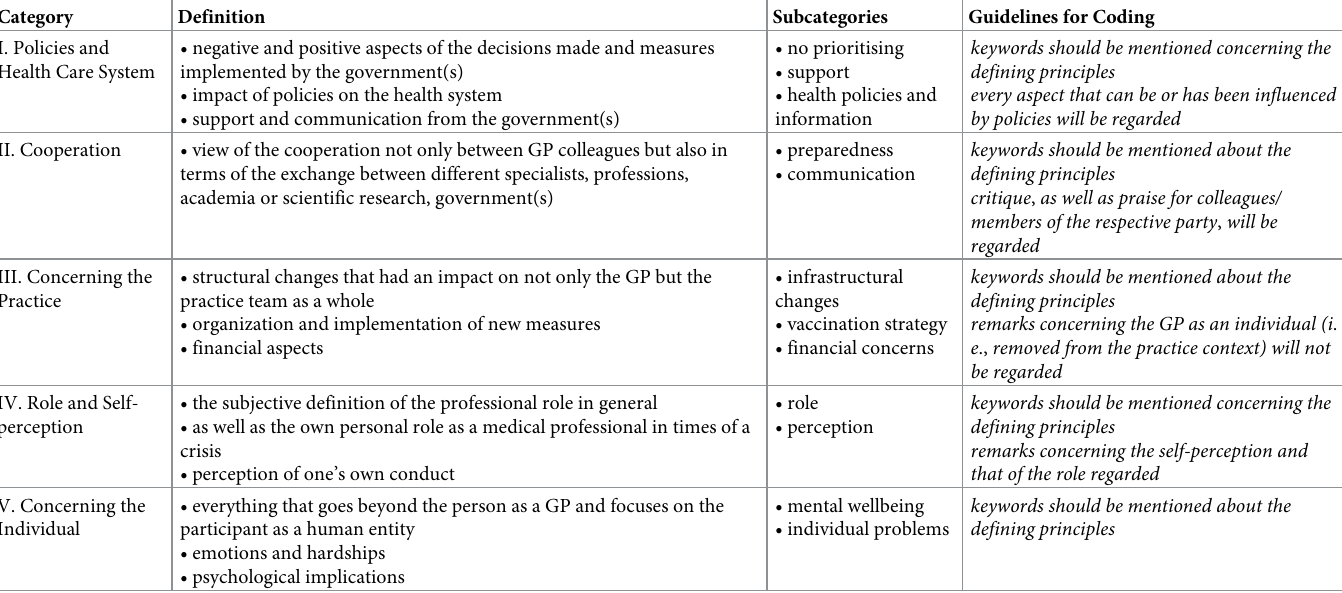
Table 3. Category system and coding